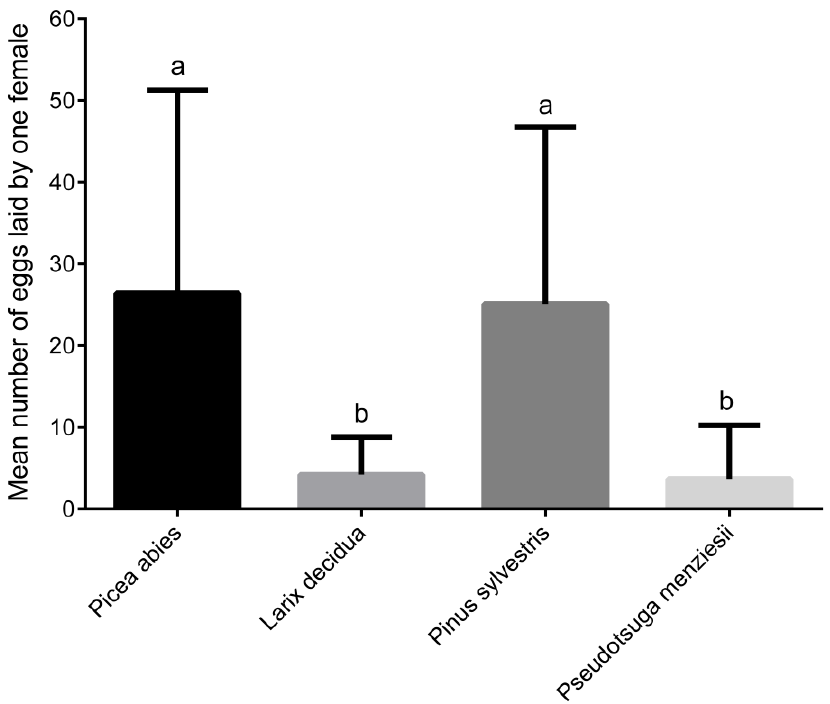
Figure 4. Number of eggs laid by female of Hylobius abietis (mean ± SD) during 28 days experimental period. Different letters above the columns indicate differences ( p < 0.05; RM ANOVA).